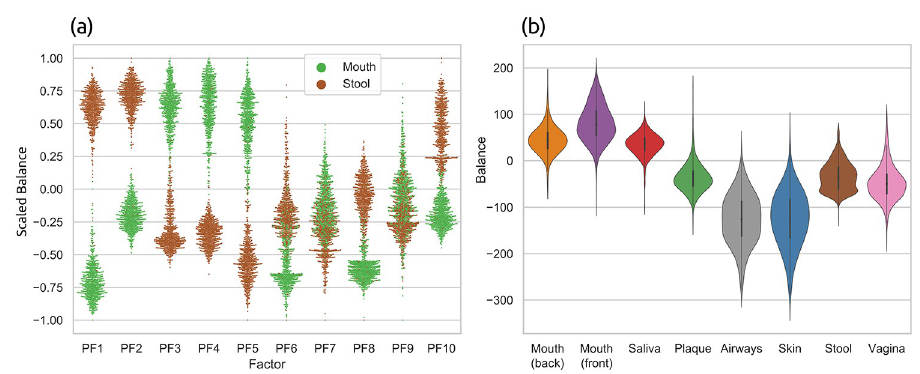
Fig 11. Ordination of Placement-Factorization of the HMP dataset. In this visualization of phylogenetic factors, we show the balances of the winning edge at different factors for all samples. Subfigure (a) shows the first 10 factors found by Placement-Factorization with taxon weighting on the oral/fecal subset of the HMP dataset. We call this a balance swarm plot . It can be understood as multi-dimensional scatter plot, where each dimension is shown separately: Each column corresponds to a factor (PF1–PF10), with the vertical axis being the balances, and horizontal space within each column used to spread samples at nearby positions, revealing their distribution density. The balances were scaled to the [ − 1.1, 1.0] interval for better comparability across factors, while keeping the centering at 0. Subfigure (b) shows the first factor of Placement-Factorization with taxon weighting on the full HMP dataset. The violin plots in (b) extend on the idea of balance swarm plots by separating different groups of samples, based on their body site. This allows to clearly see the distribution of balances at the factor for all groups of samples. The exhaustive versions of these plots, with and without taxon weighting, and for more factors, are shown in the context of the typical two- and three- dimensional scatter plots in S18, S19, and S20 Figs. See there for more